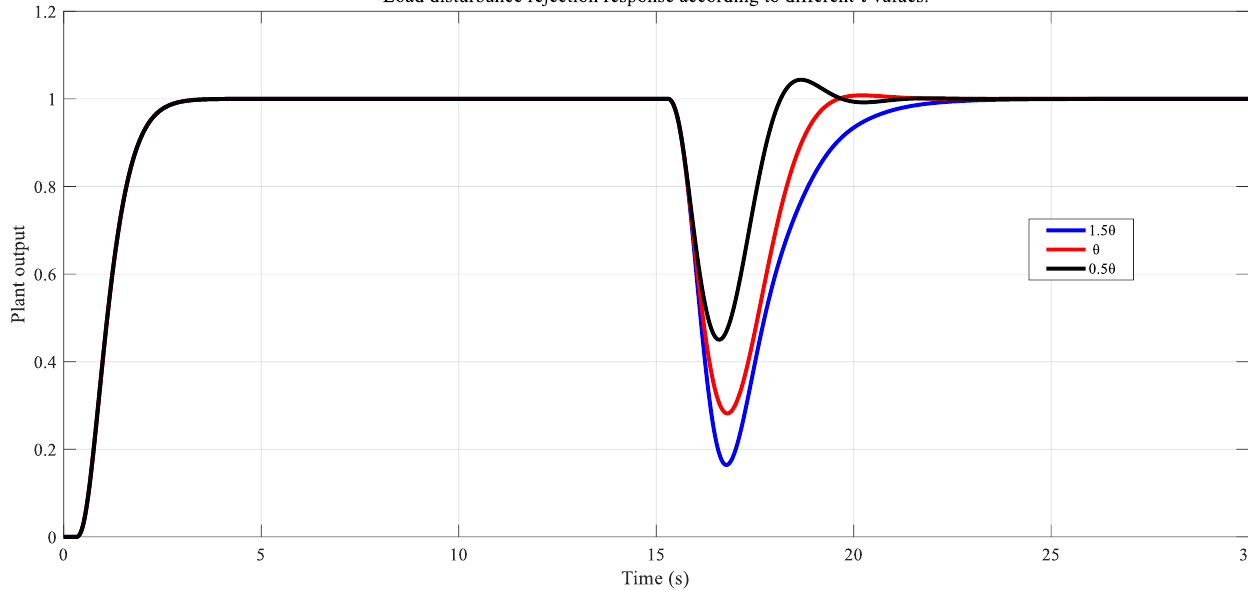
Figure 2. Load disturbance rejection response according to different τ values.